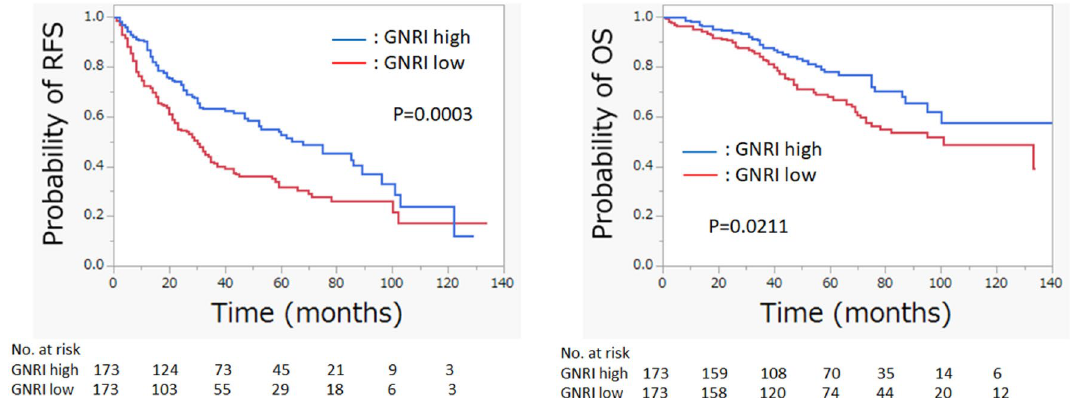
Figure 1. Kaplan–Meier curves of RFS and OS in the low- and high-GNRI groups. RFS, recurrence-free survival; OS, overall survival, GNRI, geriatric nutritional risk index.